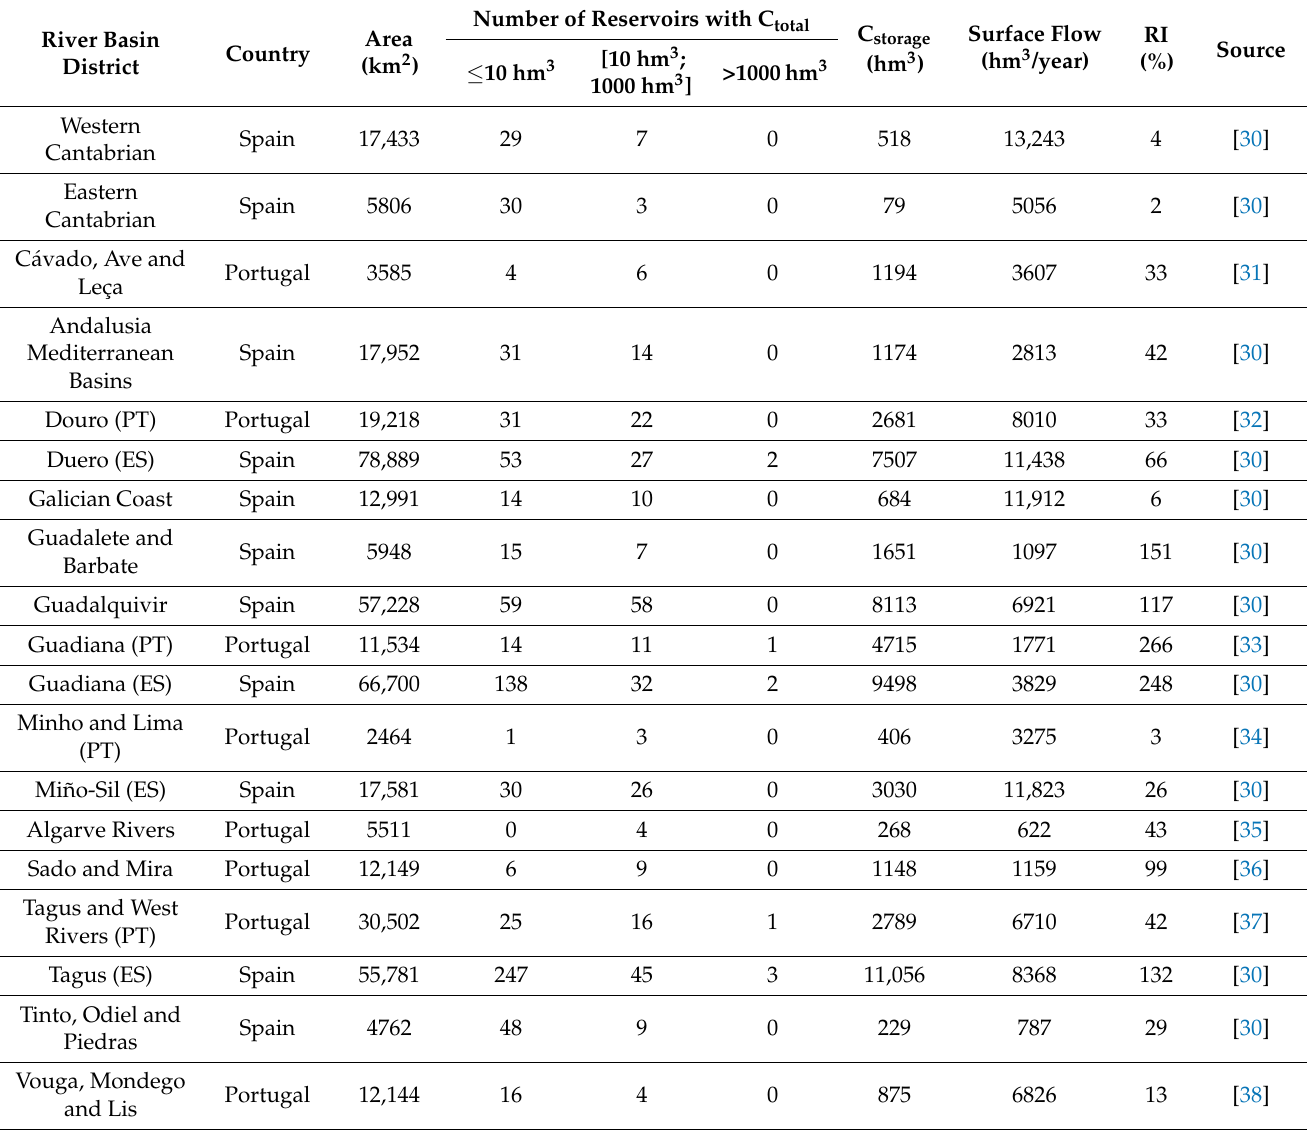
Table 1. Characteristics of the studied river basin districts (Area; number of reservoirs and respective total capacity, C total ; total storage capacity, C storage ; natural surface flow; regularization index,